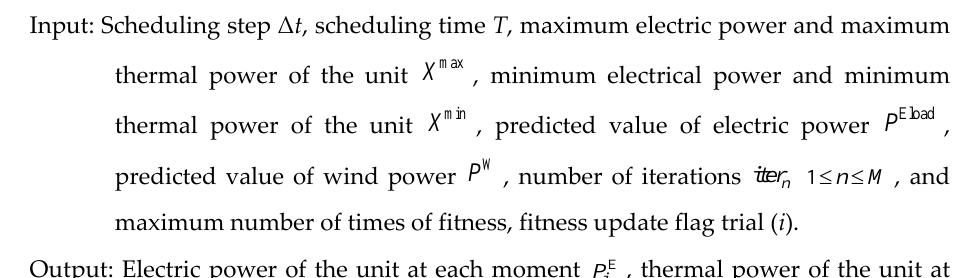
Algorithm 1 : Artificial bee colony solving method based on cross operation.